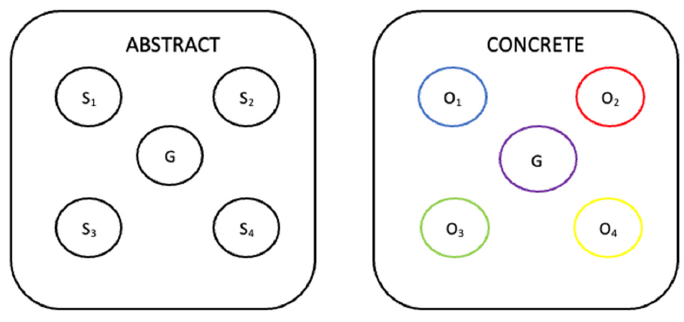
Figure 3. Ontological Structure: Pegboard (ii).